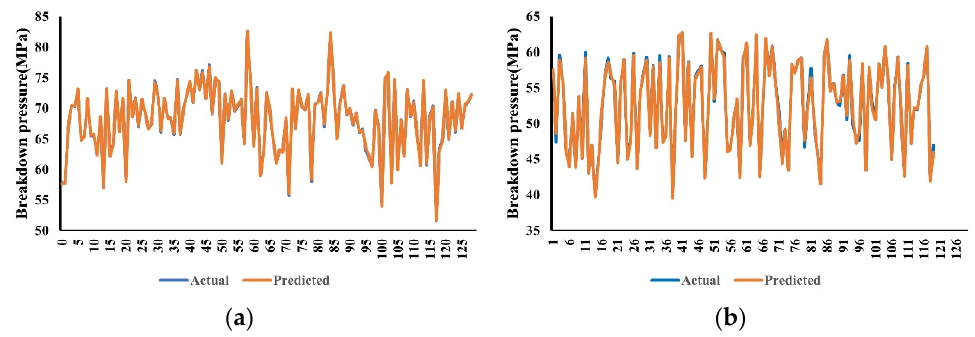
Figure 9. Comparison between linear regression predicted breakdown pressure and real breakdown pressure curves. ( a ) Correlation coefficient of open hole completion breakdown pressure prediction model. ( b ) Correlation coefficient of casing completion breakdown pressure prediction model.